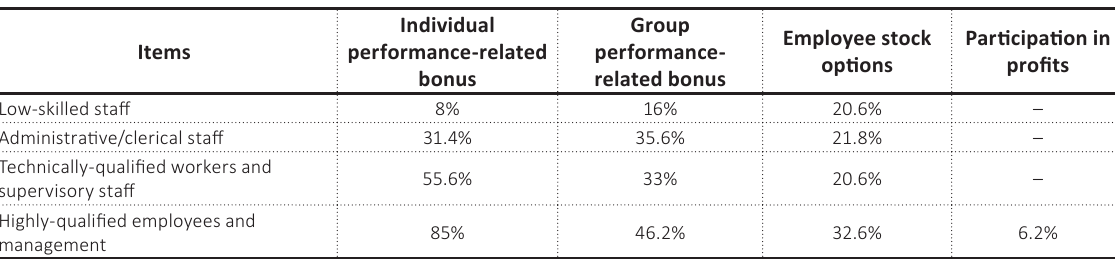
Source: Own research.